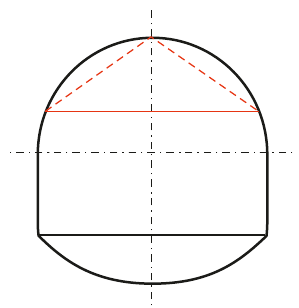
Figure 8: Similar triangle structure in the top